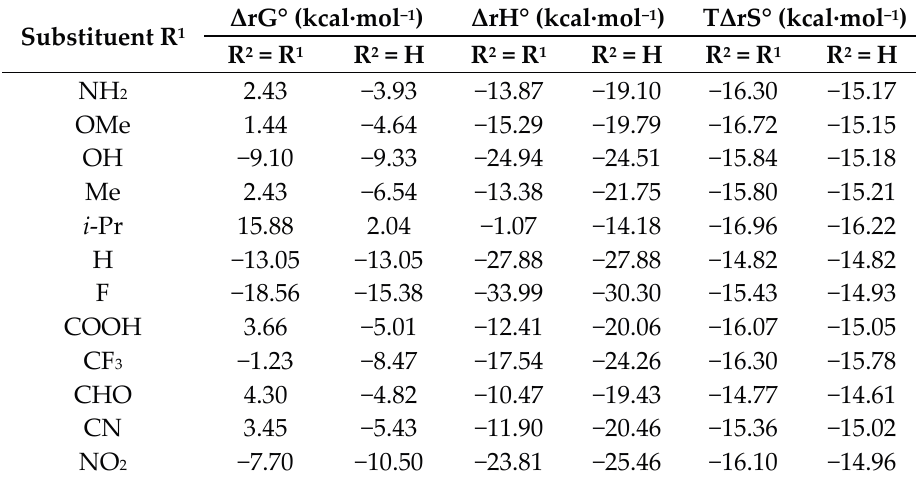
Table 2. Standard Gibbs energies Δ rG°, enthalpies Δ rH°, and entropies T Δ rS° for the reaction of butadiene with the substituted fragment 2